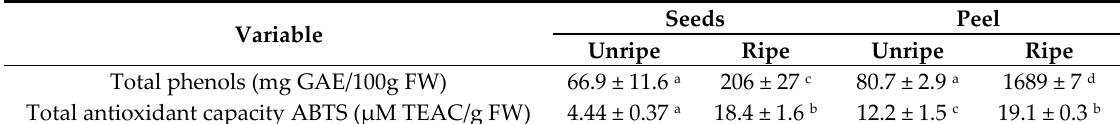
Table 4. Total phenols content and total antioxidant capacity (ABTS) in Sicana odorifera fruits seeds and